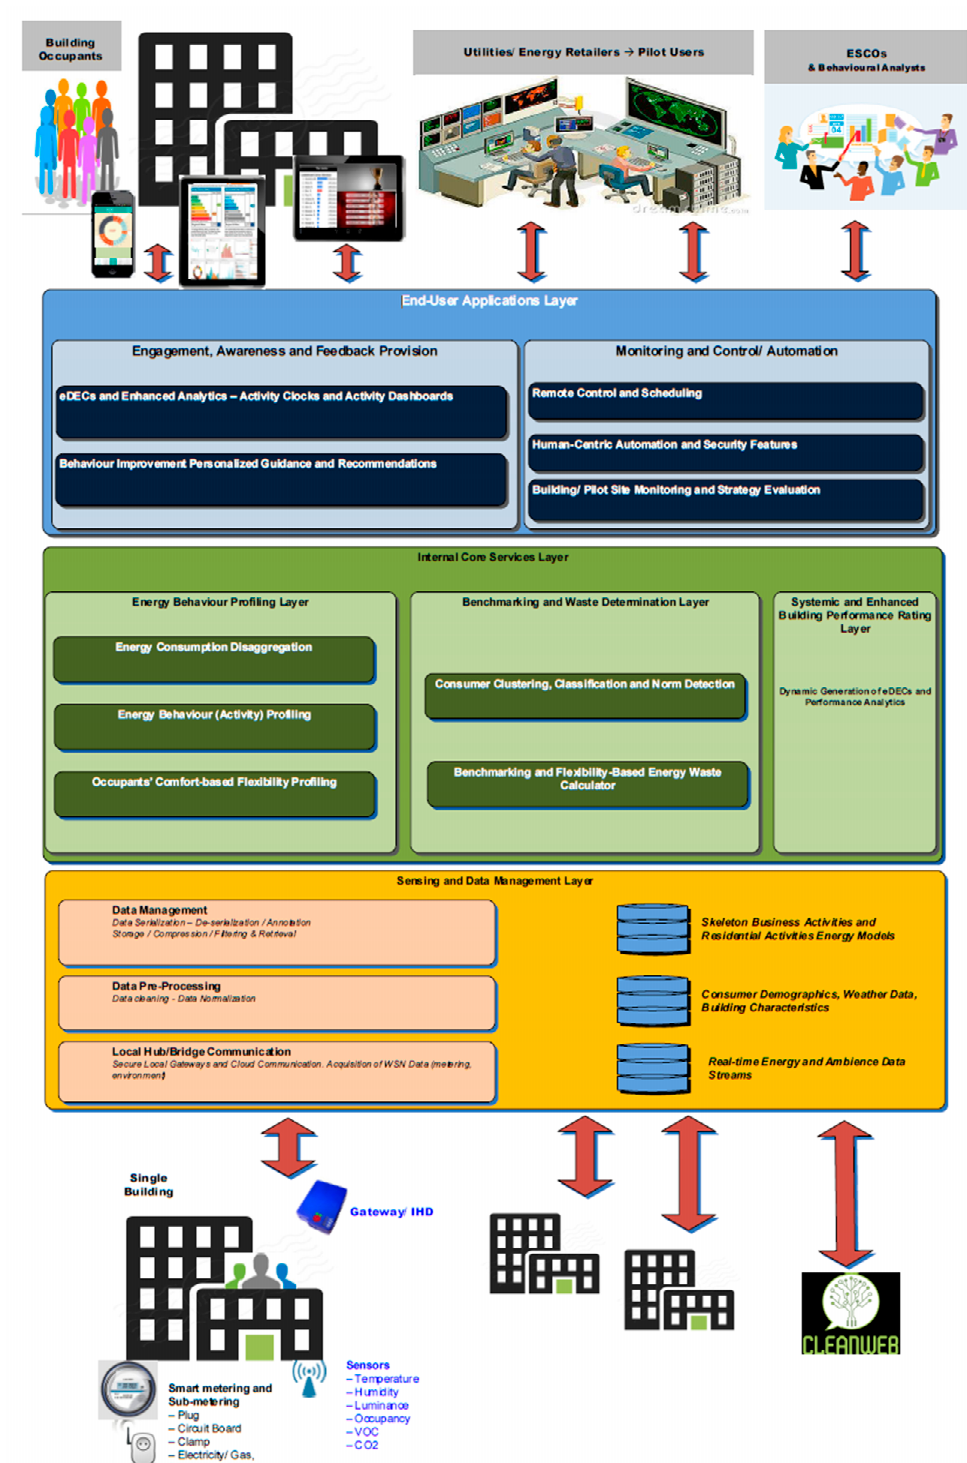
Figure A1. UtilitEE Conceptual